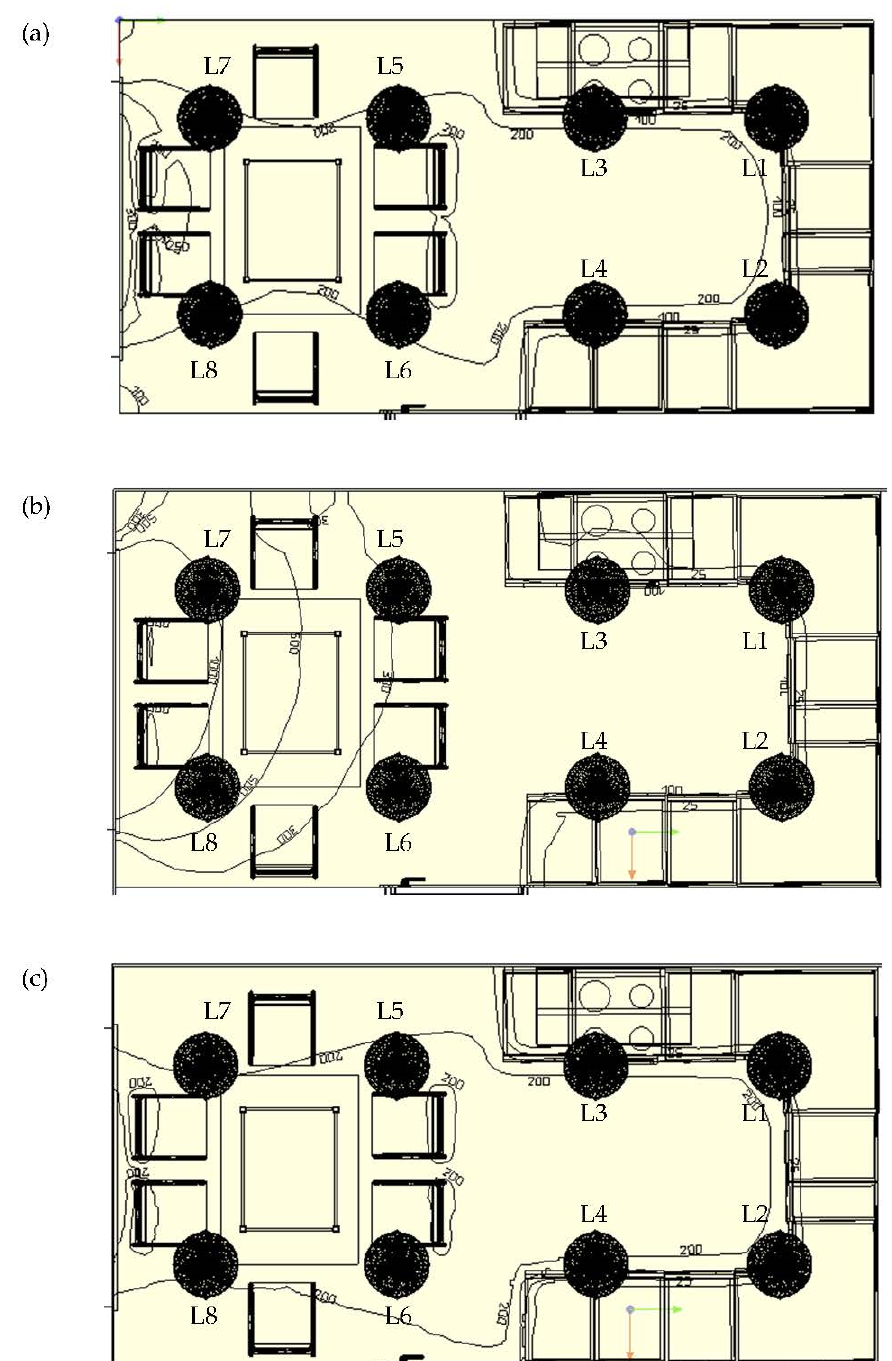
Figure 8. The even pattern of the simulation result from combining the artificial light of the smart adaptive lighting system for 200 lux illumination and the sunlight in DIALuxEvo 8.1 ( a ) at sub-scenario A, 6:00 a.m., 1 May 2019; ( b ) at sub-scenario B, 9:00 a.m., 5 June 2019, the 200 lux contour is not visible in the diagram; and ( c ) at sub-scenario C, 4:00 p.m., 10 November 2019.